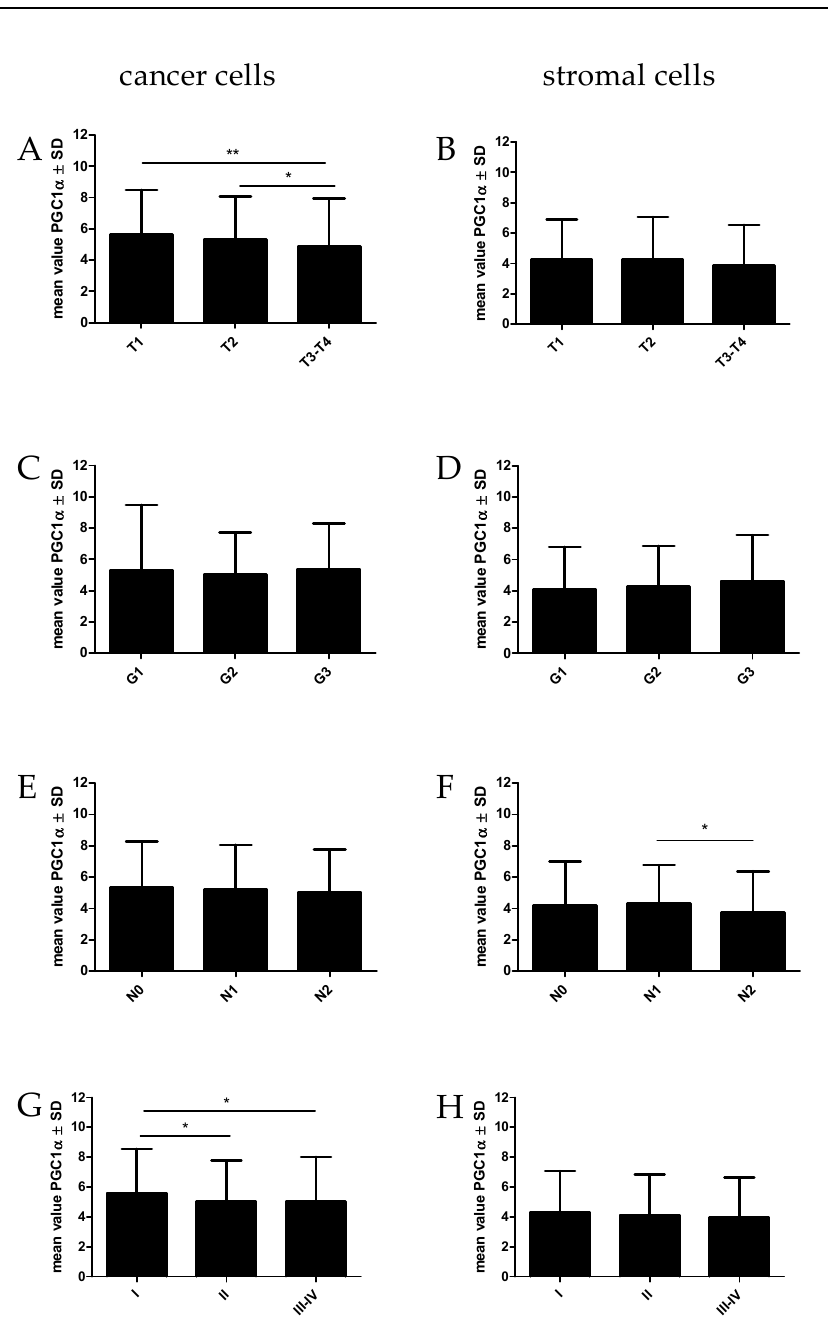
Figure 5. Comparison of PGC-1 α expression levels detected by immunohistochemistry (IHC) in NSCLC (n = 860) cells ( A , C , E , G ) and in stromal cells ( B , D , F , H ) according to the tumor size ( A , B ), malignancy grade ( C , D ), lymph node status ( E , F ), and tumor stage ( G , H ). * p ≤ 0.05, ** p ≤ 0.005.